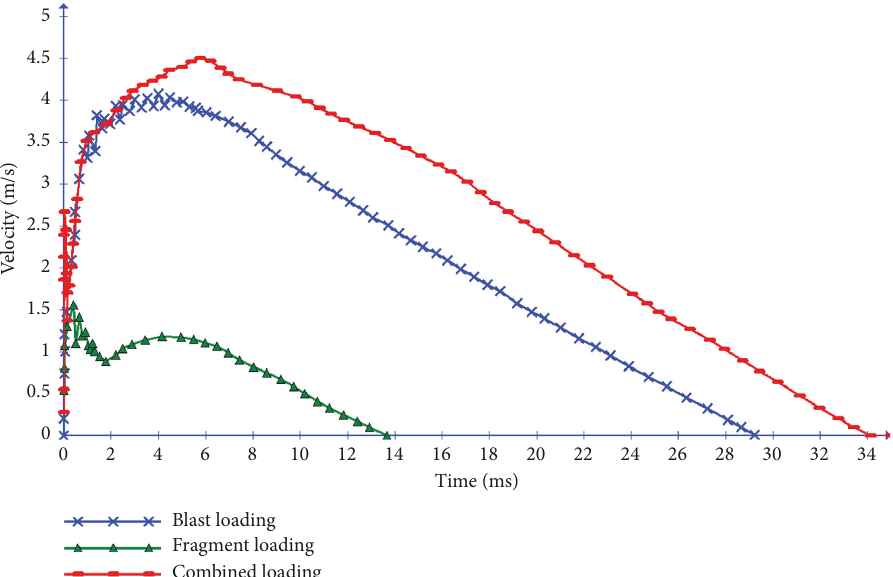
Figure 13: Velocity-time history plot for RC wall different load cases [3].